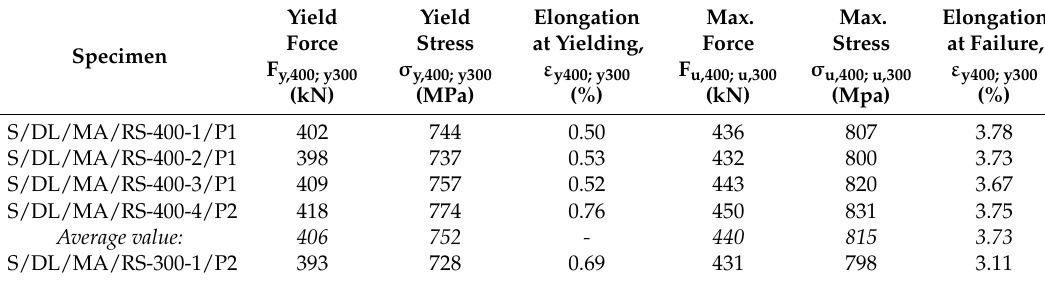
Table 4. Static test results for the specimen with 400 mm and 300 mm